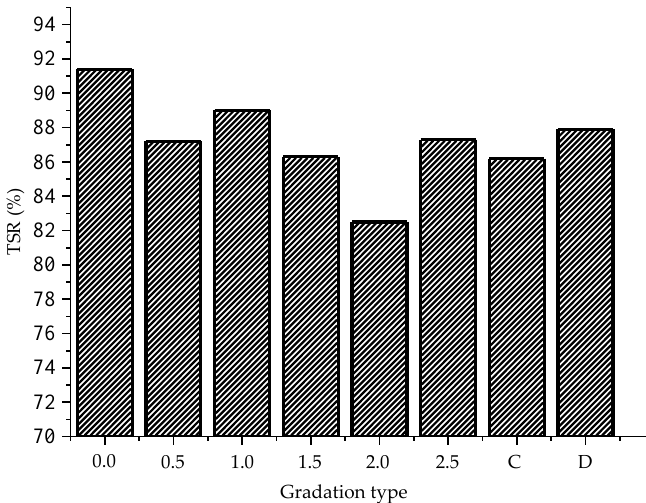
Figure 11. Freeze–thaw split test results (done 34 times).